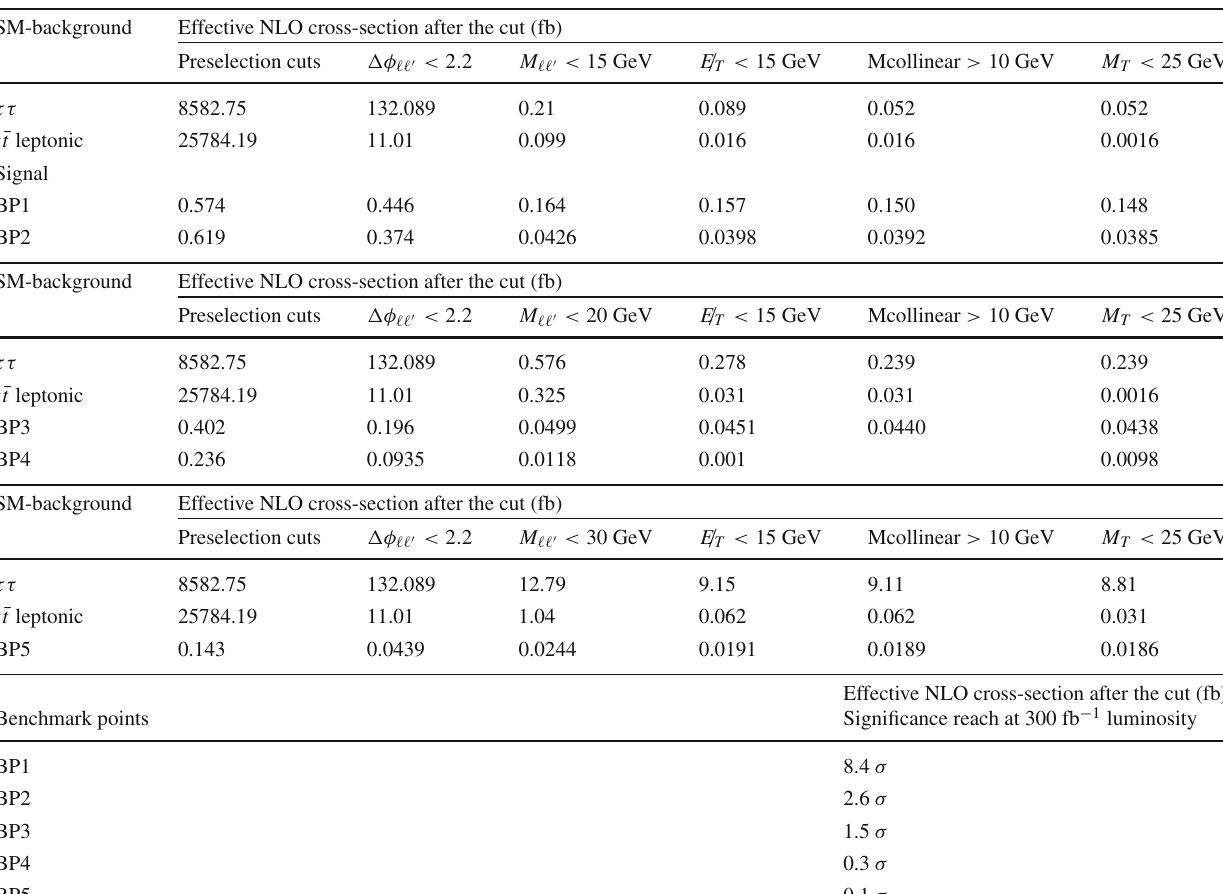
Table 2 The cut-flow for signal and background and significance reach for our signal at 14 TeV LHC for 300 fb − 1 luminosity